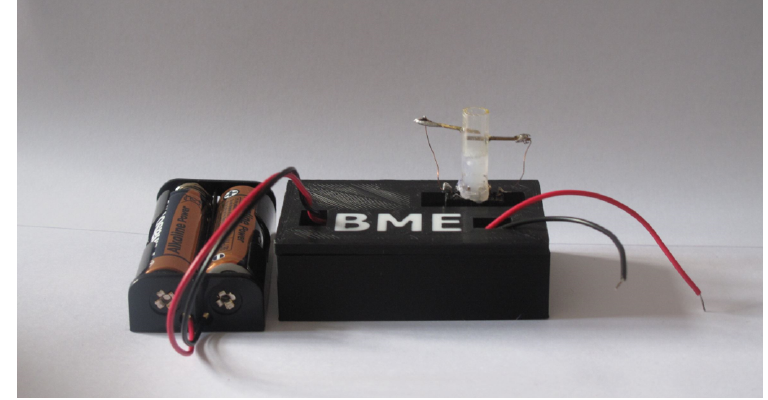
Figure 5. Complete measuring system.